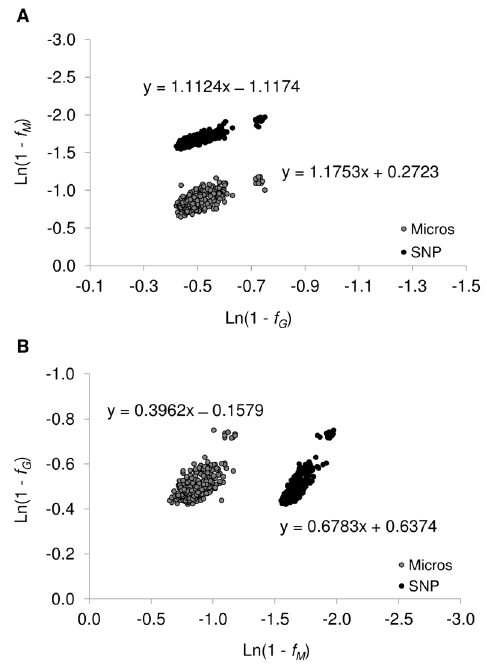
Figure 2. Predictions of SNP-based molecular coancestry ( f M ) and genealogical coancestry ( f G ) . (A) Predictions of SNP-based molecular coancestry from genealogical coancestry. (B) Predictions of genealogical coancestry from molecular coancestry. The dataset included the 219 Guadyerbas animals with SNP genotypes available. The complete pedigree information was used for the estimation of genealogical coefficients. Regression equations (including and exclud- ing self-coancestries) are indicated.